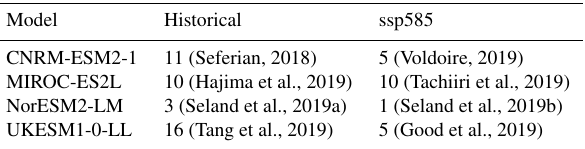
Table 2. Number of available members used in the ensemble means and (in brackets) reference for the dataset, for the historical and ssp585 CMIP6